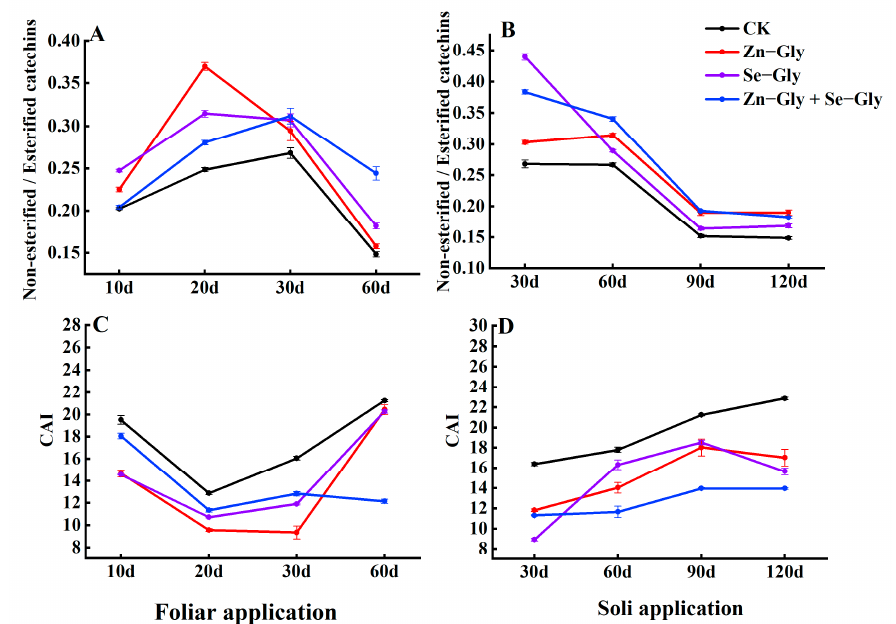
Figure 7. The non − esterified/esterified catechin index and catechin bitterness index in tea leaves under different fertilization treatments. ( A , C ) Non − esterified/esterified catechin index and catechin bitterness index in tea leaves following foliar fertilizer application; ( B , D ) Non − esterified/esterified catechin index and catechin bitterness index in tea leaves following soil fertilizer application. The abscissa shows the days of treatment. Different colors represent different treatments, as follows: black, CK; red, Zn − Gly; purple, Se − Gly; blue, Zn − Gly + Se − Gly.